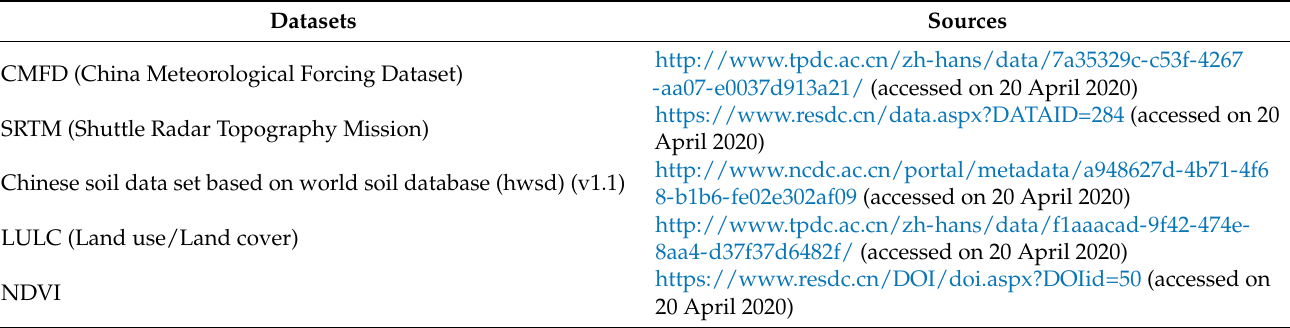
Table A1. All data sets used and their sources.